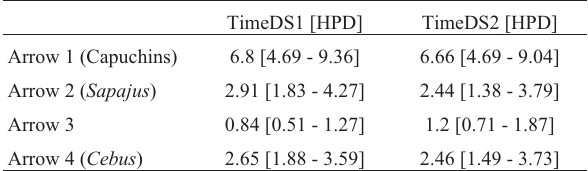
Table1 -DivergencetimesforcapuchinmonkeysandtheirHPD(Highest Posterior Density) intervals estimated from four different databases. Ar- rows 1, 2, 3 and 4 can be seen in Figures 3 and 4.